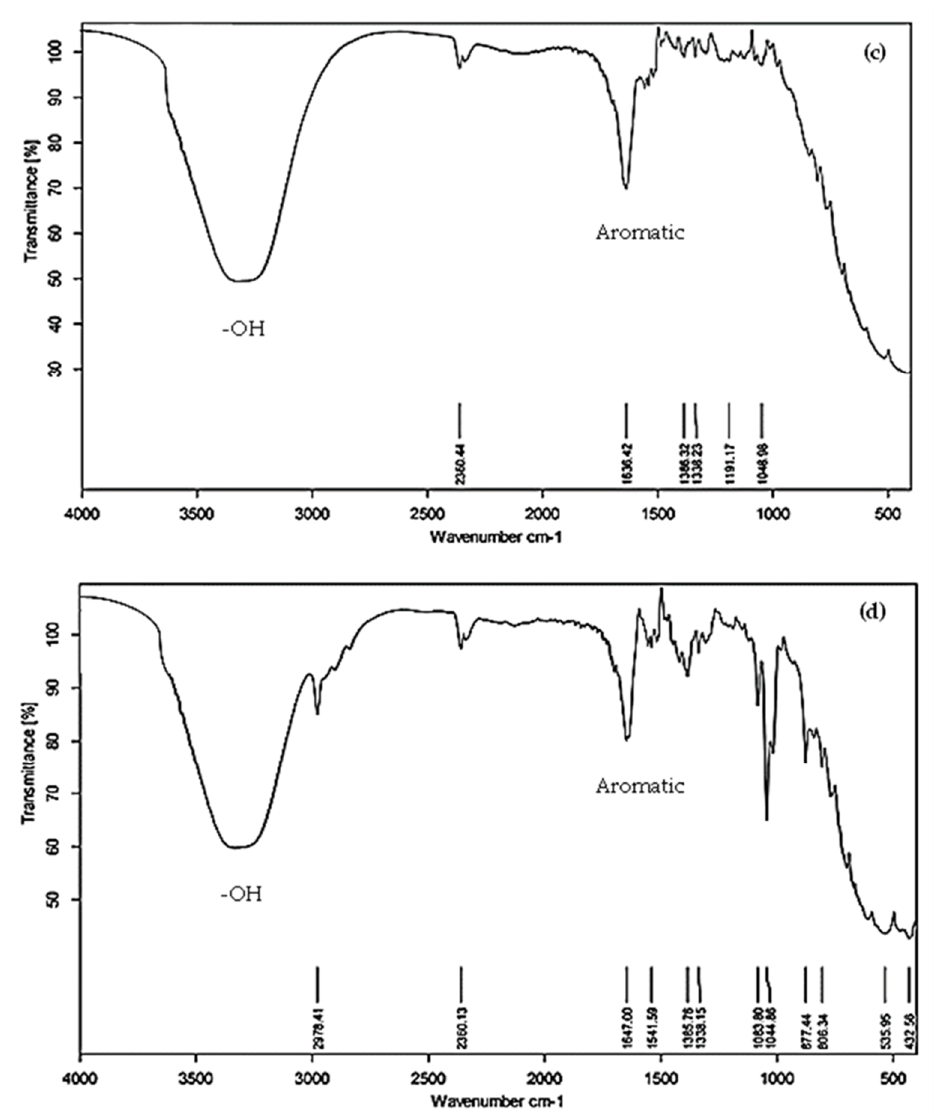
Figure 2. FTIR analysis of aqueous ( a ), alkaline ( b ), acidic ( c ), and basified methanol ( d ) extract of rose. Table 1. Antibacterial activity of different rose extracts and their dyed fabrics against Escherichia coli and Staphylococcus aureus